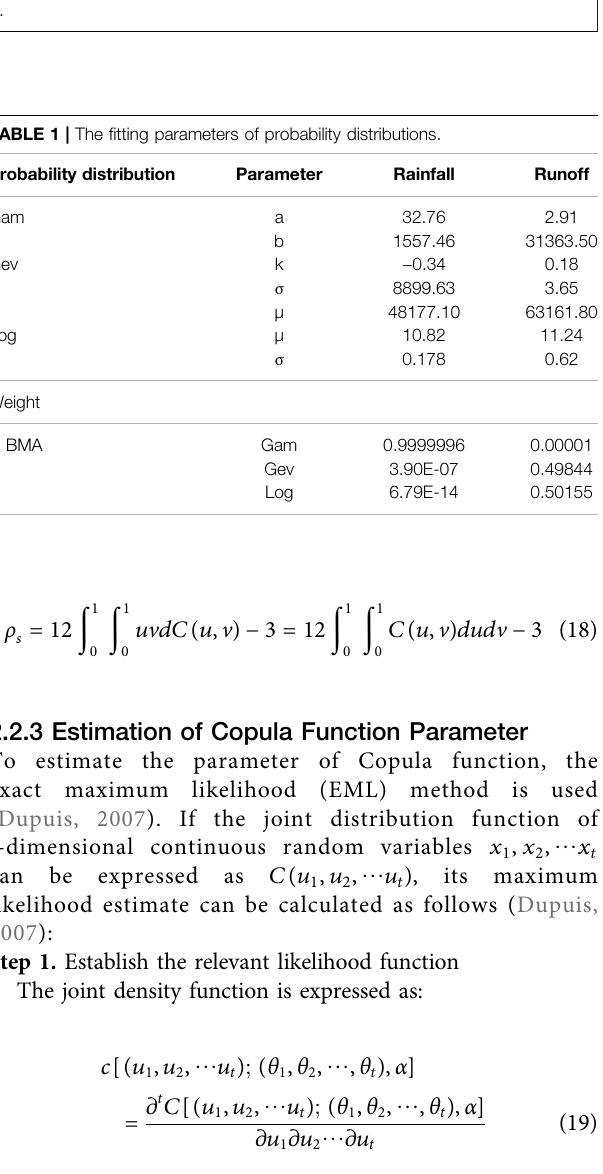
FIGURE 4 | The Histogram of mothly rainfall and runoff in the Xiangxi River watershed.